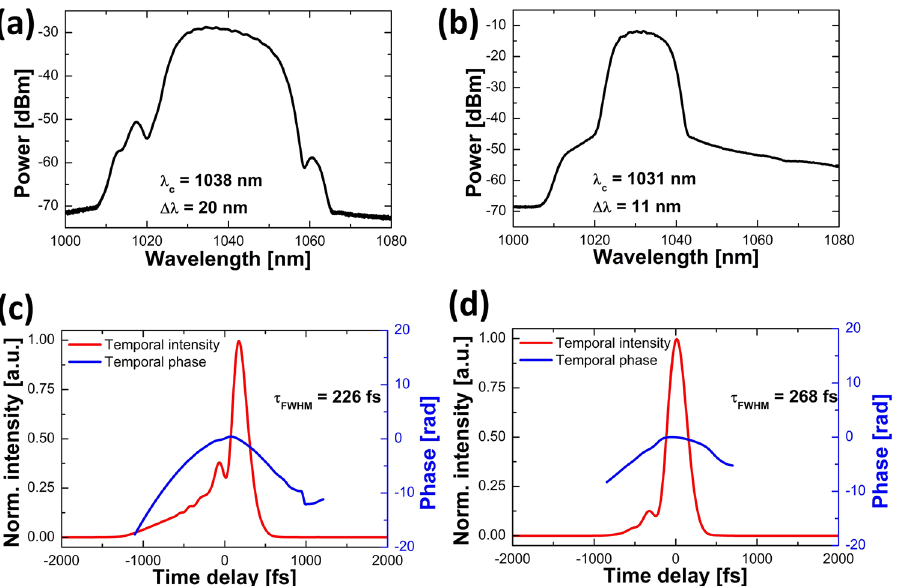
Figure 2. Characterization of seed pulses launched into the amplifier: optical spectrum for ( a ) the high- repetition-rate and ( b ) the low-repetition-rate seed source, together with FROG-retrieved temporal intensity (solid red line) and temporal phase (solid blue line) for ( c ) the high-repetition-rate and ( d ) the low-repetition- rate seed source.